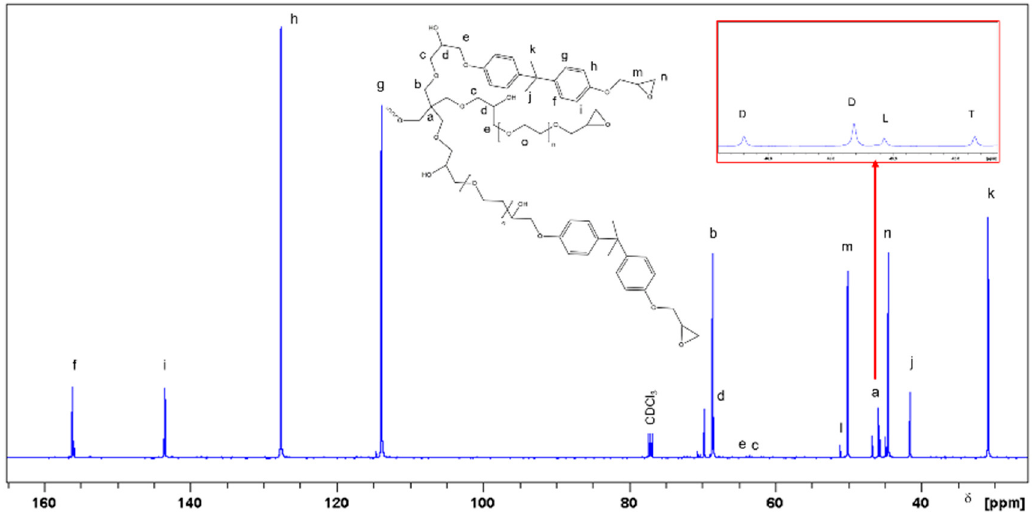
Figure 5. 13 C NMR spectrum of HBE5P resin.